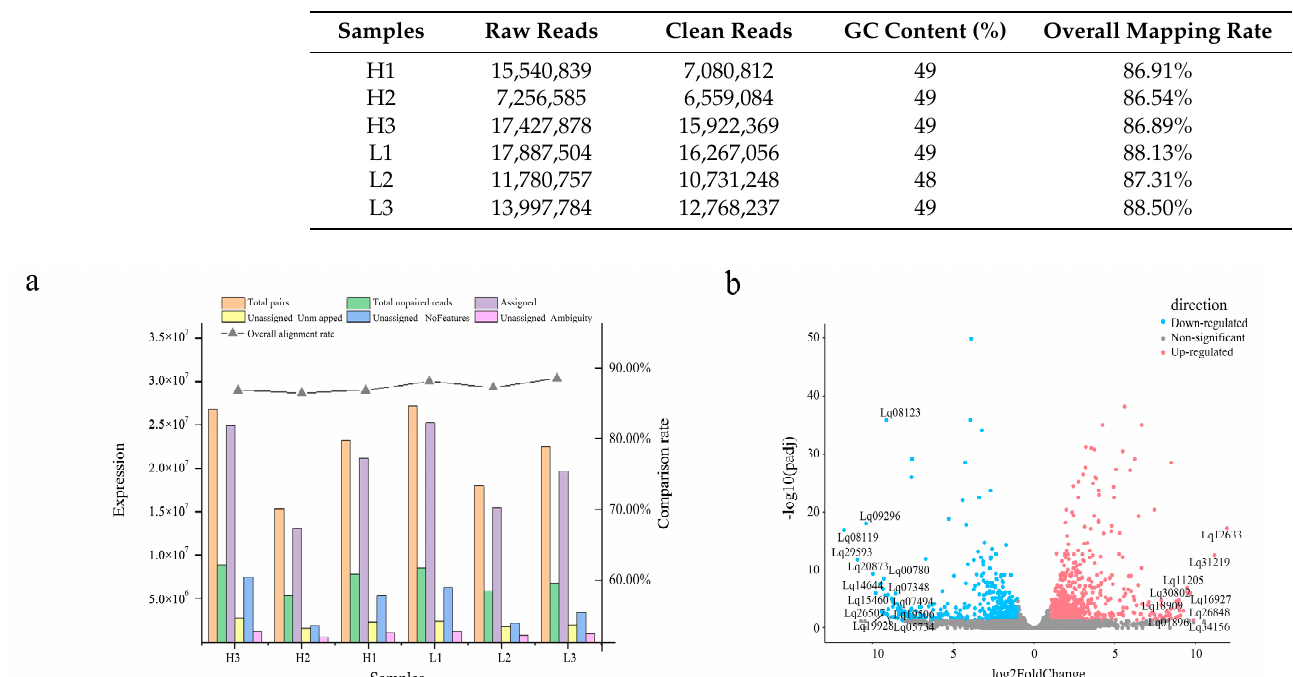
Table 1. Transcriptome sequencing quality and mapping rate of leaves L. formosana .